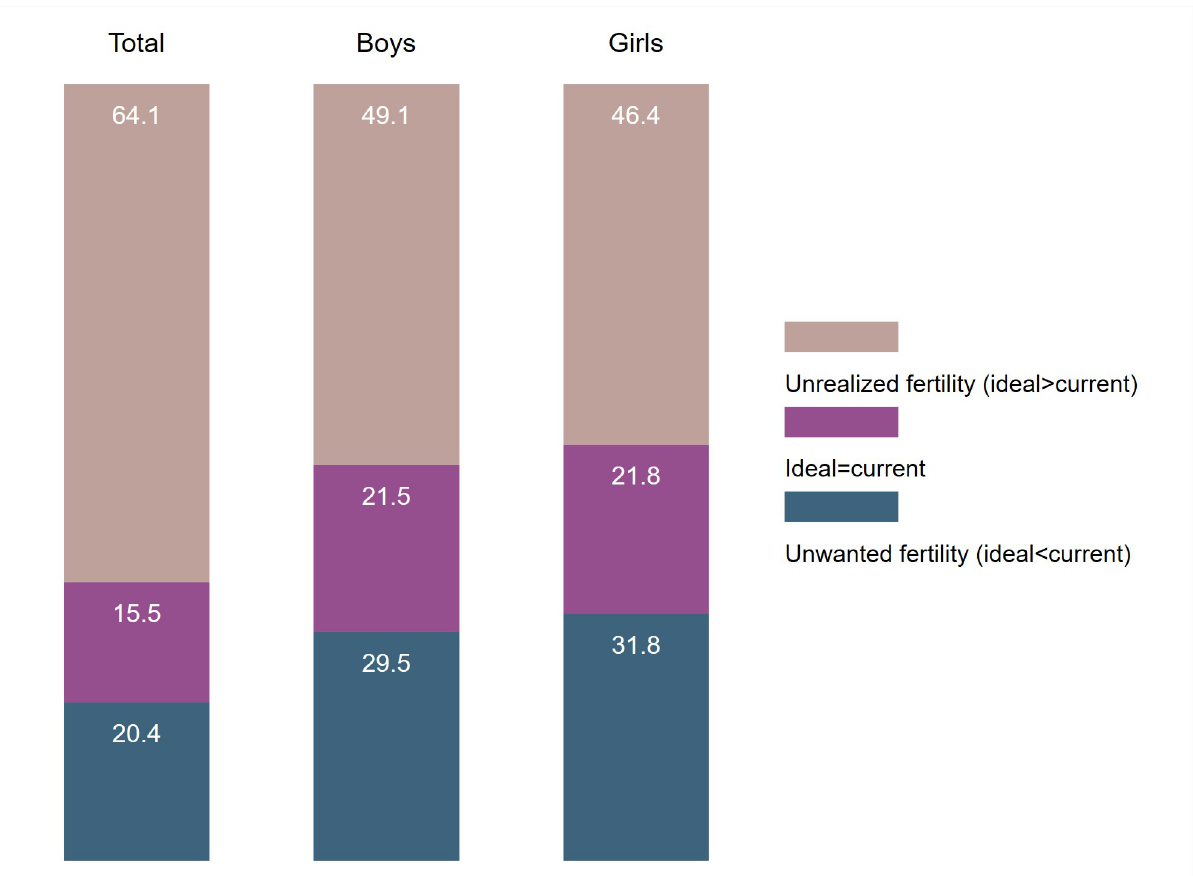
Fig 2. Distribution of ideal minus current number of children among women age 44–48, Western and Central Africa.